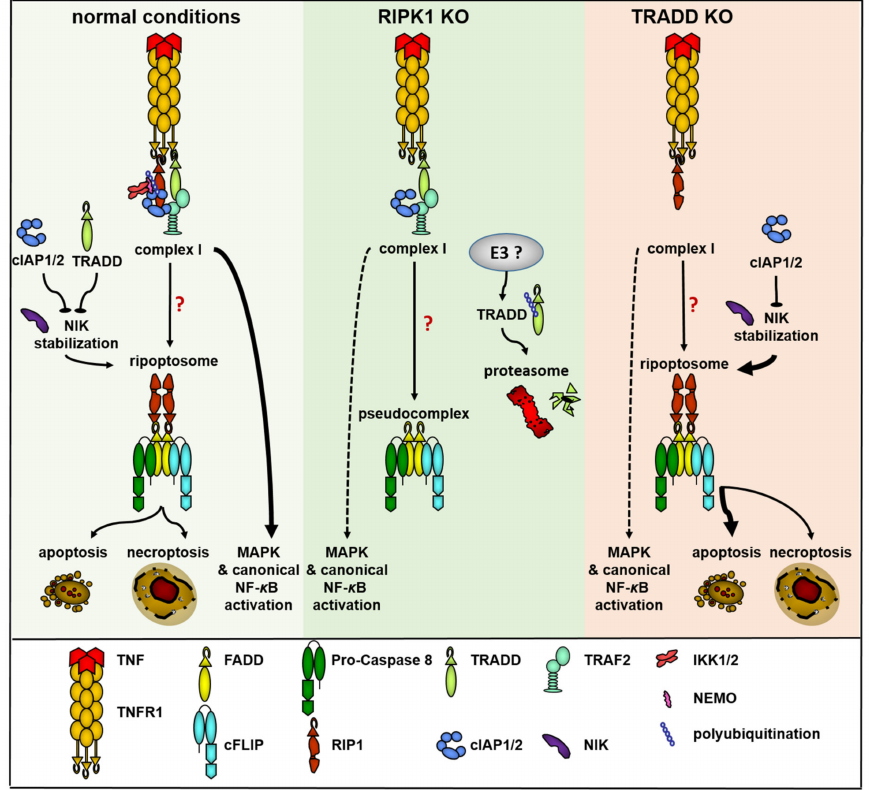
Figure 6. Suggested model of TRADD and RIPK1 functions in TNF signaling and ripoptosome formation. Under normal conditions (yellow field), the signal initiated by TNF through TNF-R1 proceeds via the assembly of TNF complex I and initiates NF- κ B and MAPK signaling. Assembly of complex I and stabilization of NIK are the requirements for ripoptosome formation, which can direct the cell to apoptosis or necroptosis. NIK stabilization can be blocked by cIAPs or TRADD. When RIPK1 is missing (green field) complex I is assembled but NF- κ B and MAPK signaling are partially blocked. No ripoptosome is formed. The assembly of pseudocomplex is unable to direct the cell-to-cell death. Unknown E3 ubiquitin ligase can ubiquitinate TRADD and direct it to proteasomal degradation. When TRADD is missing (red field), complex I consists only of unmodified RIPK1 and both NF- κ B and MAPK signaling are partially blocked. NIK stabilization is simplified and ripoptosome is assembled and can direct the cell to apoptosis or